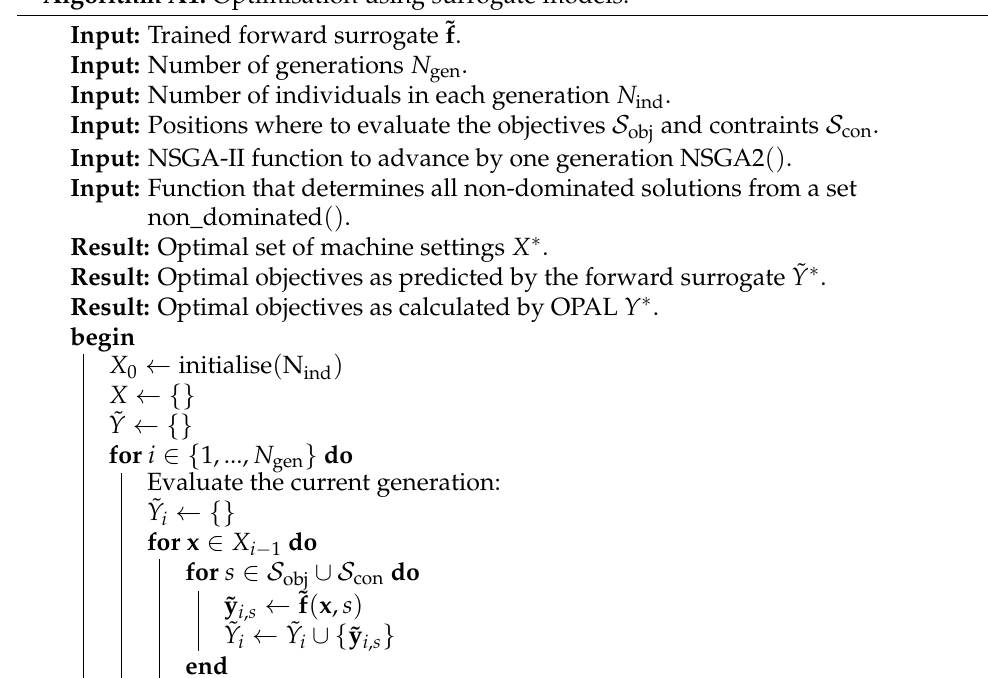
Algorithm A1: Optimisation using surrogate models.